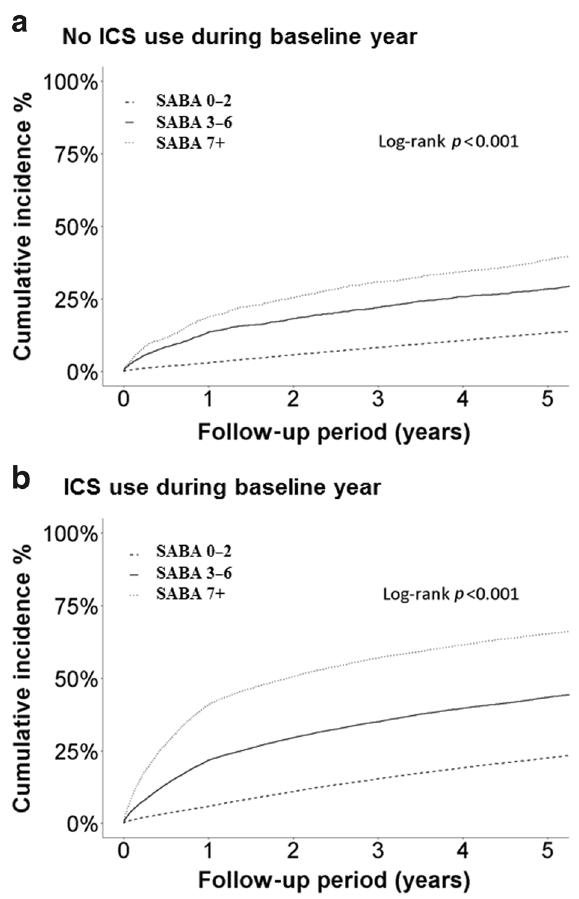
Fig. 1 Incidence of asthma exacerbation. Kaplan – Meier plot of the incidence of asthma exacerbation by baseline SABA use among non-ICS uses ( a ) and ICS-uses ( b